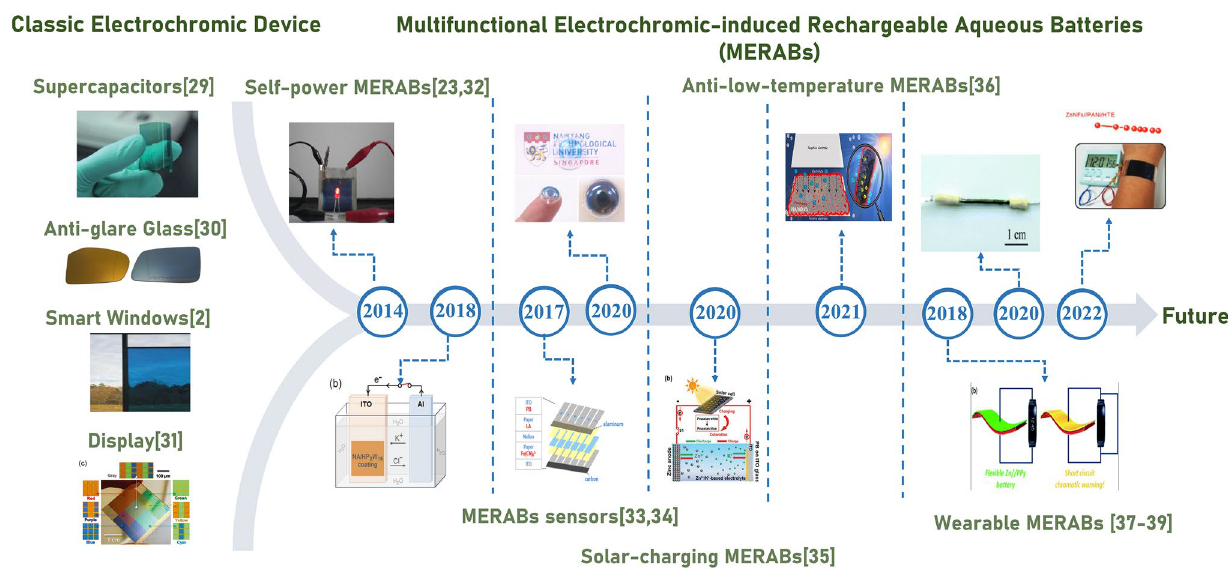
Fig. 1 A comprehensive overview of the progress of MERABs: from classic electrochromic device to emerging MERABs. From left to right: reproduced with permission [2]. Copyright 2010, Elsevier. Reproduced with permission [29]. Copyright 2012, Royal Society of Chemistry. Reproduced with permission [30]. Copyright 2015, IOP Science. Reproduced with permission [31]. Copyright 2016 Wiley–VCH. Reproduced with permission [23]. Copyright 2014, Springer Nature. Reproduced with permission [32]. Copyright 2018, Wiley–VCH. Reproduced with per- mission [33]. Copyright 2017, MDPI. Reproduced with permission [34]. Copyright 2020, Elsevier. Reproduced with permission [35]. Copyright 2020, Wiley–VCH. Reproduced with permission [36]. Copyright 2021, American Chemical Society. Reproduced with permission [37]. Copy- right 2018, Royal Society of Chemistry. Reproduced with permission [38]. Copyright 2020, Royal Society of Chemistry. Reproduced with per- mission [39]. Copyright 2022,